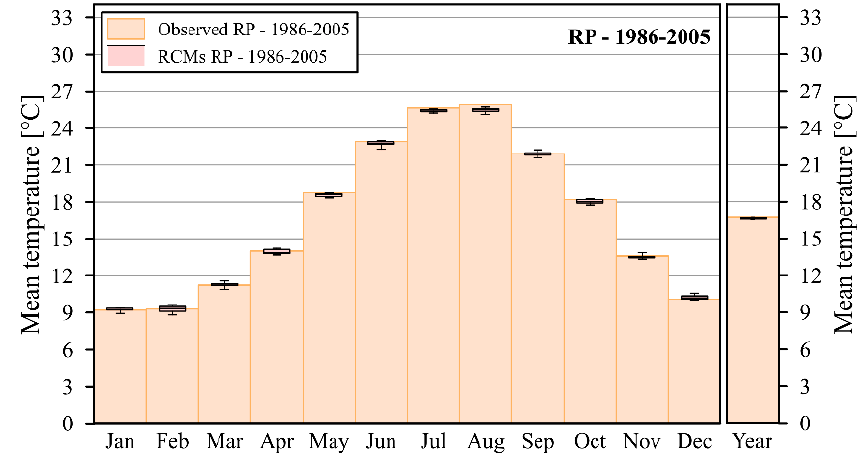
Figure 8. Monthly and annual mean temperature over the Salento area, observed and evaluated by the RCMs in the reference period (RP). The box-whisker plots represent the variability between the 13 RCMs (the whiskers indicate the minimum and maximum values).